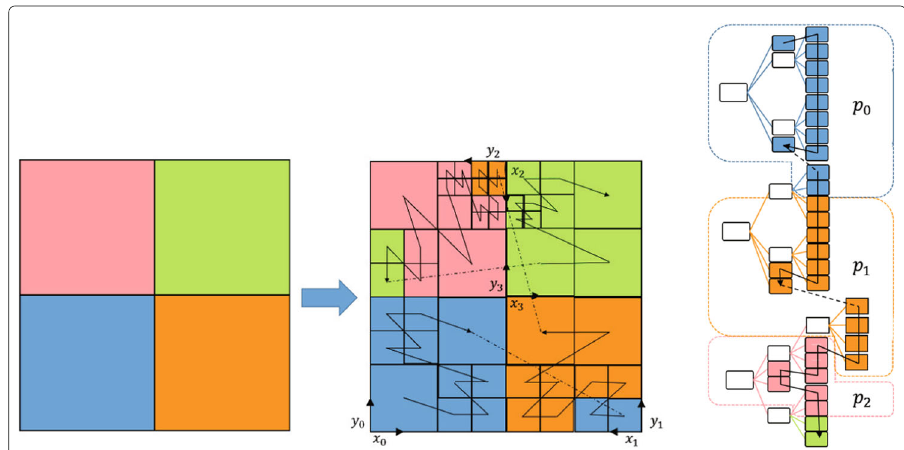
Fig. 5 Left: Z-order curve traversal of the quadrants in four trees with different orientation of the forest and partition into four processes which are distinguished by different colors. Right: the corresponding representation of the domain using a